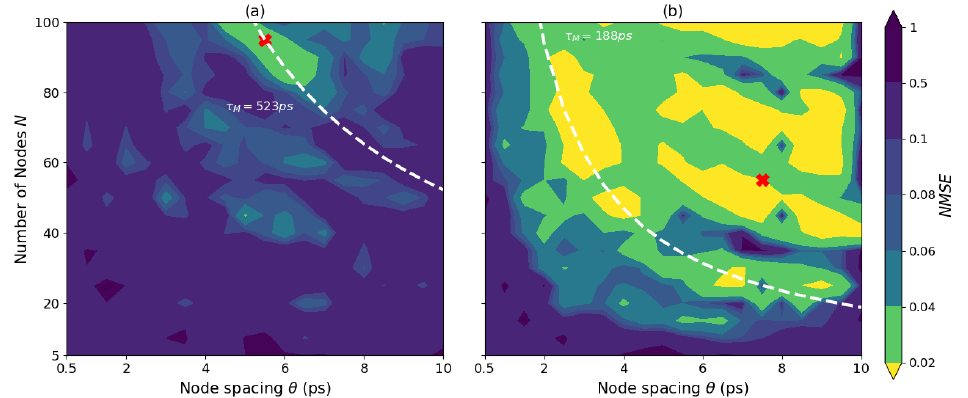
Figure 4. Santa Fe timeseries prediction performance, indicated by the NMSE , color-coded unto the parameter space spanned by N and θ for ( a ) τ D = 150 ps and η = 1 ns − 1 , and ( b ) τ D = 15 ps and η = 100 ns − 1 . The red crosses denote the minimum NMSE achieved over the scanned space and the white dashed lines are a guide to the eye, denoting a constant mask length τ M (cid:54) = τ D